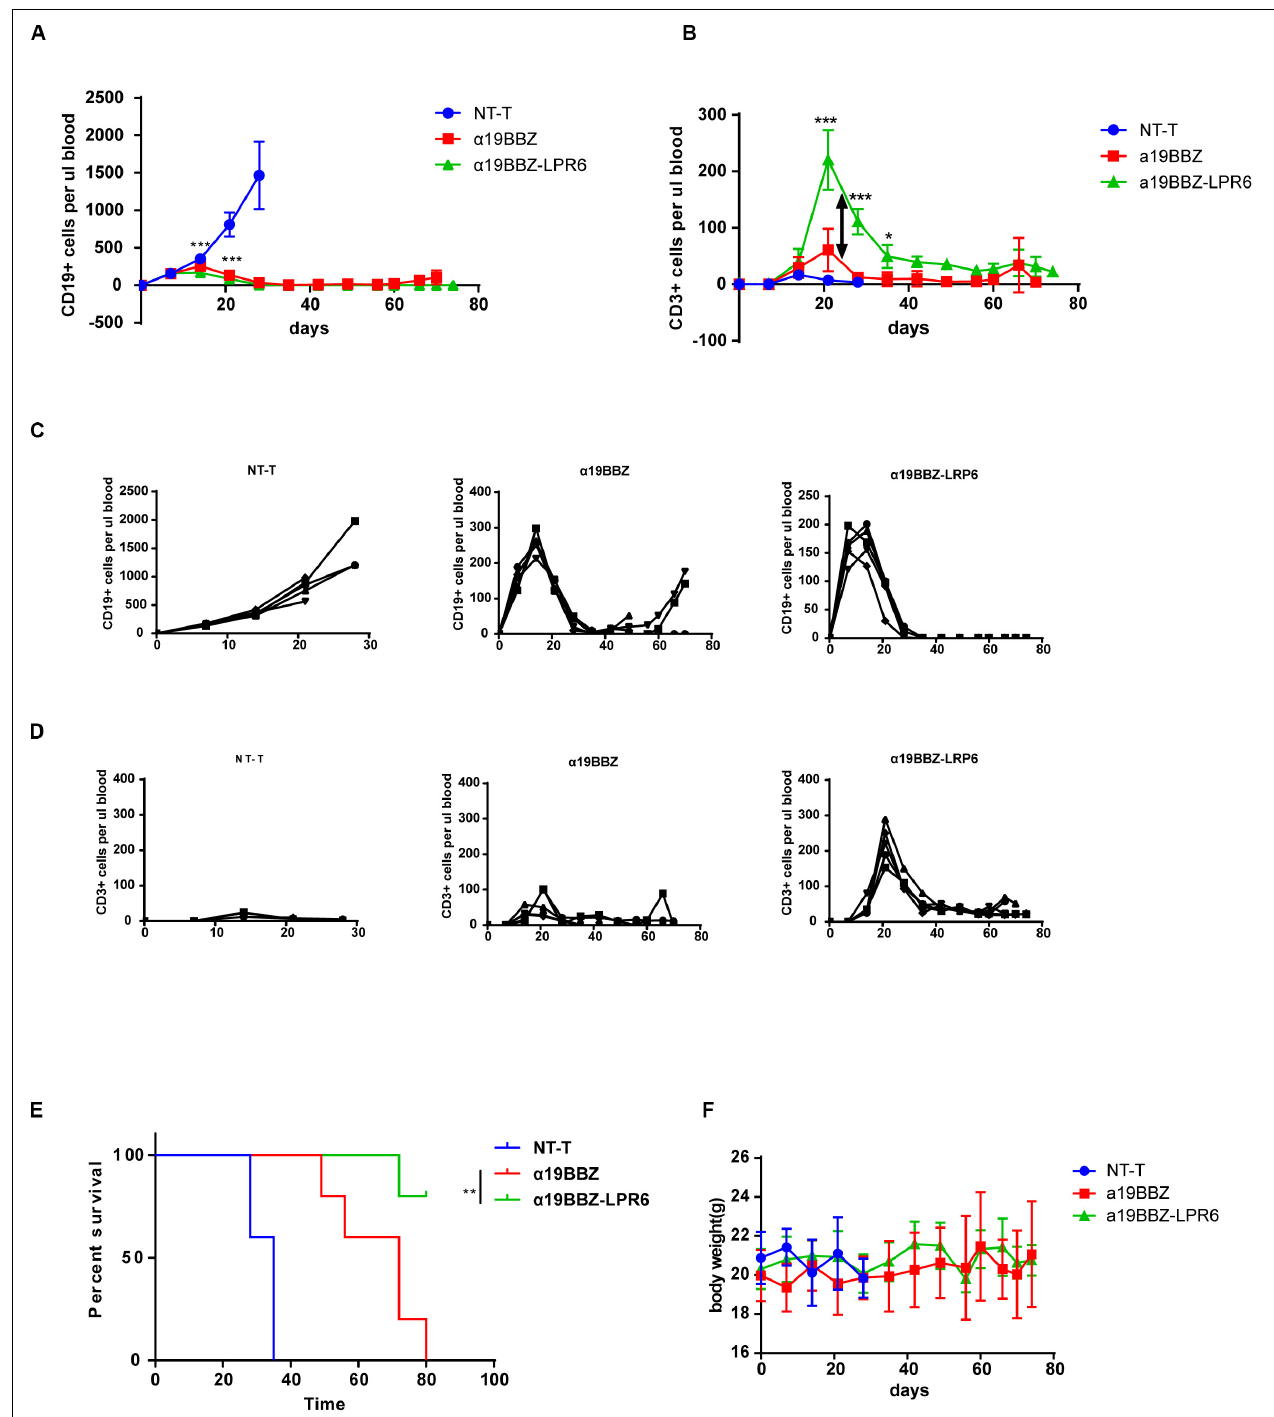
FIGURE 4 | Antitumor efficacy of CAR-T cells in Nalm6 xenograft model. (A,B) Representation of the human CD19-positive tumor cells surviving in the peripheral blood. (C,D) Representation of the human CD3 + T cells in the peripheral blood. (E) Representation of the mice survival curve calculated using the Kaplan-Meier method. (F) The curve of body weight of mice. Error bars indicate mean ± SD ( n = 5), * P < 0.05; ** P < 0.01; *** P < 0.001; **** P < 0.0001.